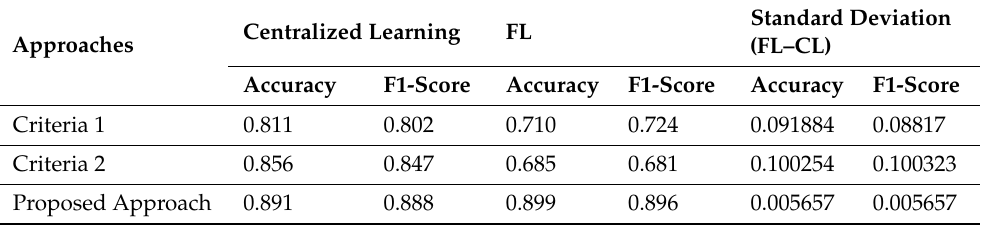
Table 8. Accuracy and F1-score assessment versus the two starting points. Baseline 2 is training data containing unrelated images, Criteria 1 (manual label) is the best scenario, where each instance is carefully tagged and evaluated when compared to Baseline 2 and Baseline 1 across both datasets. The suggested technique achieves a significant improvement in human physical activities in the disaster situation dataset